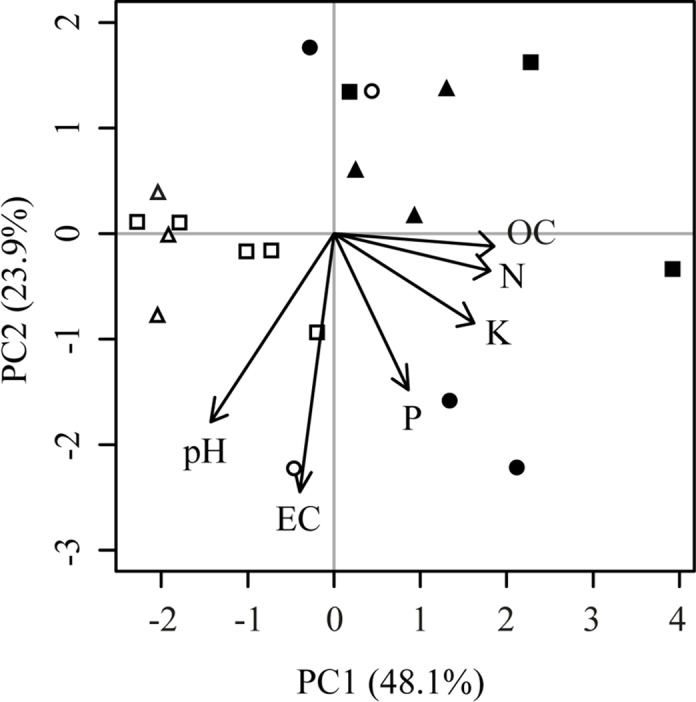
Principal component analysis of soil chemical variables.Empty and filled symbols correspond to soils from Jujuy and Salta, respectively. Shape of symbol represents land use: forests (circles), short-term (triangles) and long-term agriculture (squares).